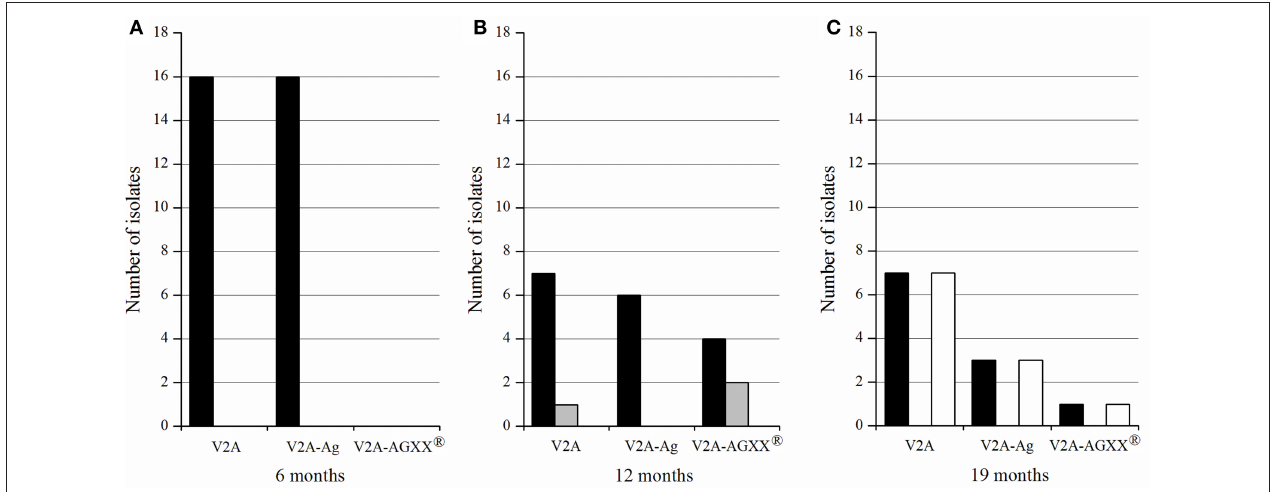
FIGURE 1 | Number of Gram-positive pathogenic bacteria recovered from the different materials (V2A, V2A-Ag, V2A-AGXX ® ), after 6 months (A) , 12 months (B) , and 19 months (C) exposure on the ISS. In black, Staphylococcus spp.; gray, E. faecalis ; white, B. cereus .